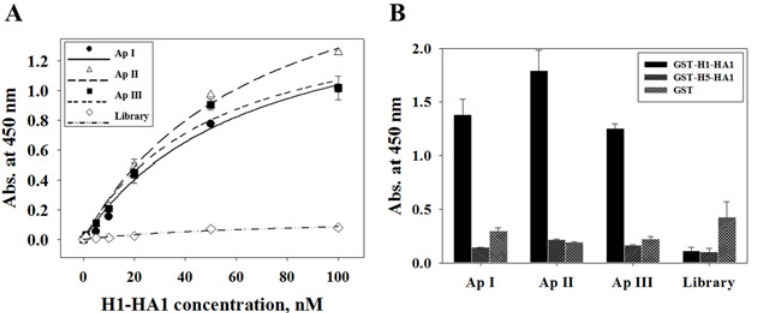
Fig 2. Binding analysis of selected ssDNA aptamers by ELISA. (A) Affinity measurements of selected ssDNA aptamers to H1-HA1 by ELISA. Immobilized biotinylated ssDNA aptamers were incubated with increasing concentrations of GST-H1-HA1, and binding was detected with anti-GST antibody-HRP. The biotinylated ssDNA library was used as negative control ( ^ ). Graphs were fitted to the Michaelis-Menten equation, and K d values were calculated as 64.76 ± 18.24 nM for ApI ( ● ), 69.06 ± 12.34 nM for ApII ( 4 ), and 50.32 ± 14.07 nM for ApIII ( & ). (B) 100 nM GST-H1-HA1, GST-H5-HA1, or GST proteins incubated with biotinylated aptamers immobilized on streptavidin-coated plates to compare binding affinities.